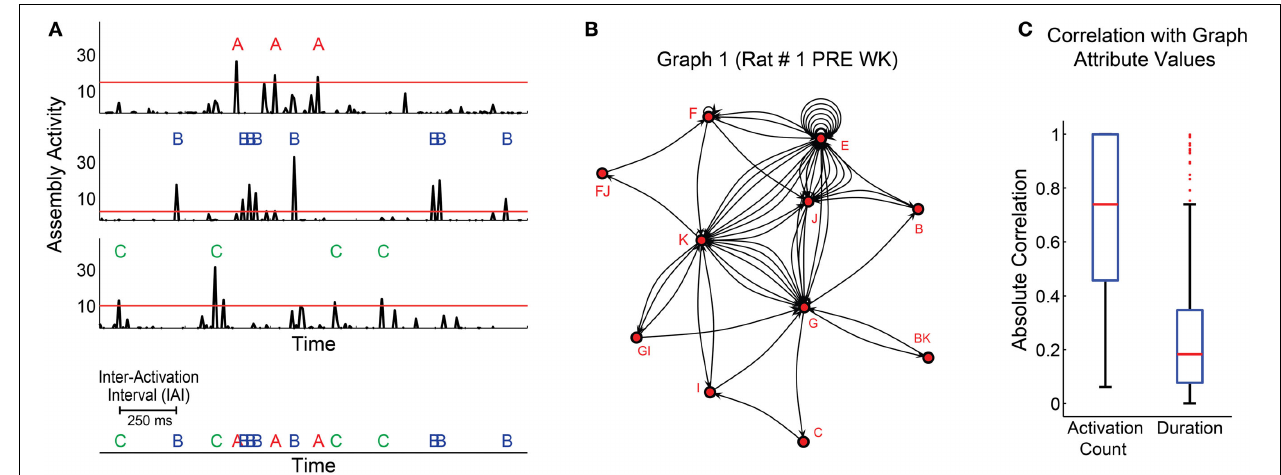
FIGURE 4 | Determination of sequences of cell assembly activations. (A) 1.5s interval showing activity of 3 assemblies (A–C) of rat # 1 (3 top panels). Thresholds are the 99th percentiles of the activity values for each assembly. Threshold-crossing peaks are considered assembly activations. Assembly activation sequence is defined as the series of activation across different assemblies within subjects; and the time interval between two subsequent activations is called inter-activation interval (IAI) (bottom panel). (B) Exemplary graph generated with assembly activations from the first WK